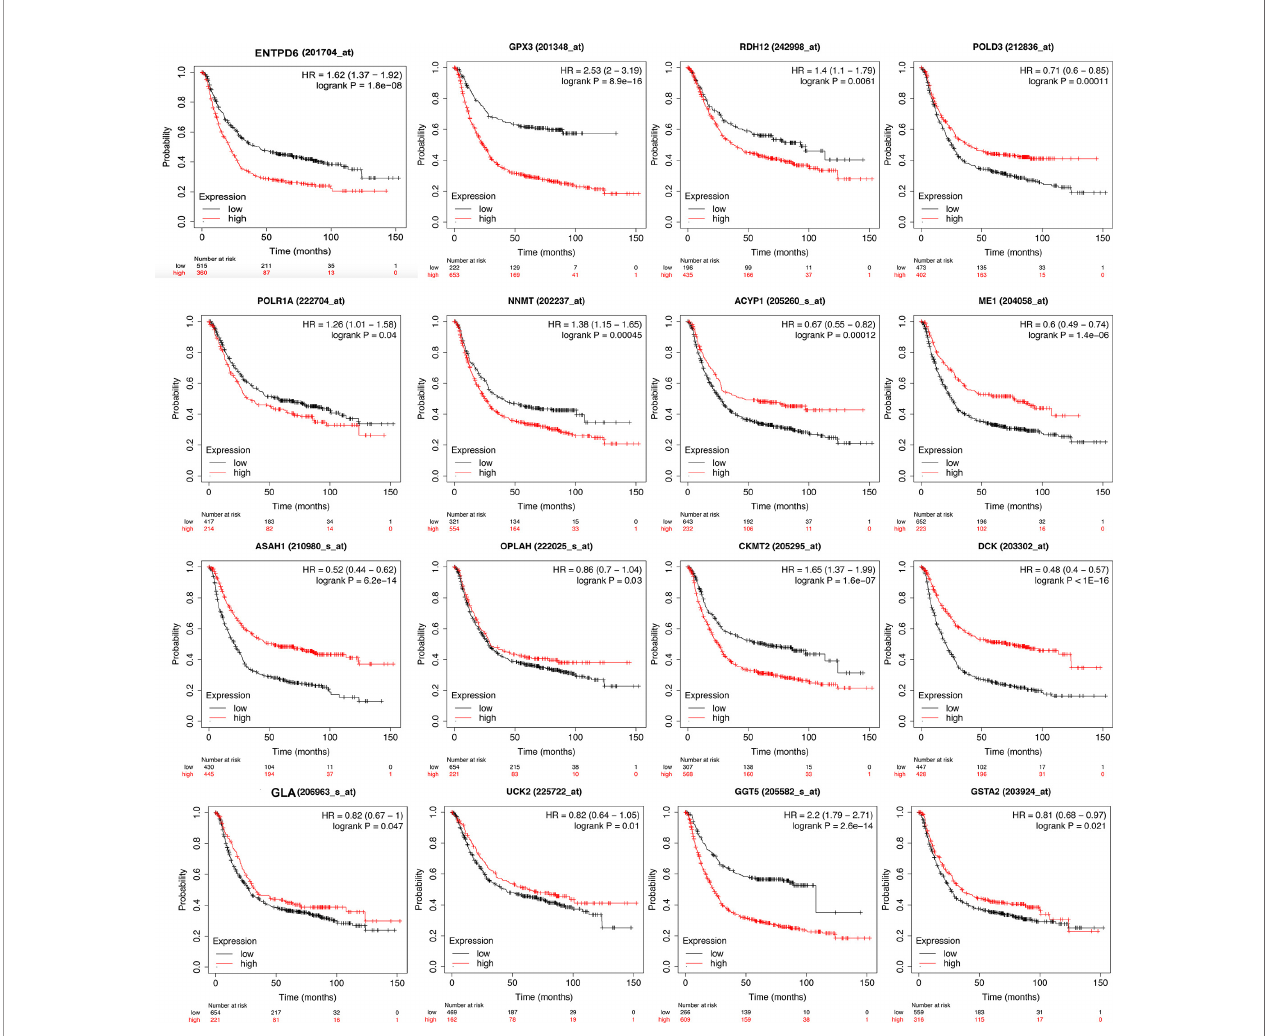
FIGURE 4 | Kaplan-Meier survival curve of overall survival associated with differentially expressed metabolism-related genes (DEMRGs) in stomach adenocarcinoma (STAD). The DEMRGs associated with overall survival of patients with STAD were ENTPD6 , GPX3 , GSTA2 , POLD3 , GLA , UCK2 , GGT5 , DCK , CKMT2 , ASAH1 , OPLAH , ME1 , ACYP1 , NNMT , POLR1A , and RDH12 (p <